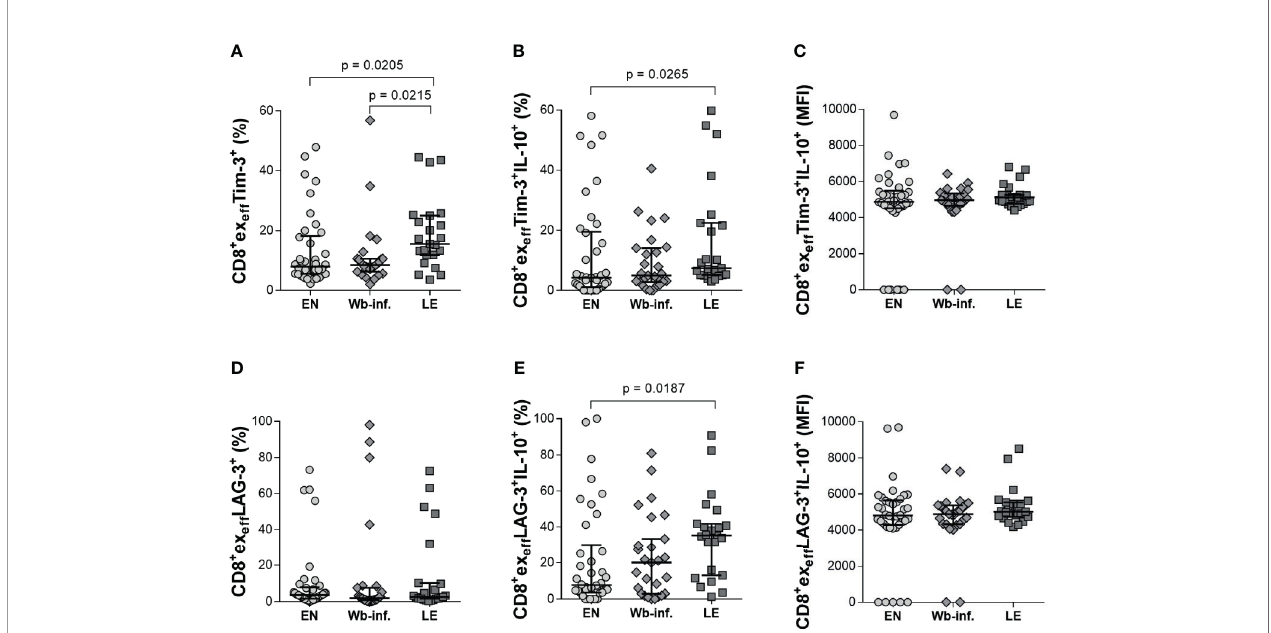
FIGURE 4 | Increased levels of IL-10 in CD8 + ex eff Tim-3 + and LAG-3 + cell subsets in patients displaying lymphedema. Cell populations were analyzed according to the applied gating strategy ( Supplementary Figure S3 ). To determine the exhaustion state of speci fi c immune cells, CD8 + ex eff Tim-3 + (A – C) and LAG-3 + (D – F) cell subsets of endemic normals (EN, n = 38), Wuchereria bancrofti infected individuals (Wb-inf., n = 27), and participants suffering from lymphedema pathology (LE, n = 23) were analyzed regarding their ability to produce IL-10 [frequencies shown in (A, B, D, E) are given in percent, median fl uorescence intensity shown in (C, F) is given in counts]. Symbols in graphs show data points with median and IQR. Statistical signi fi cance between the groups was obtained using Kruskal-Wallis followed by Dunn ’ s multiple comparison post hoc